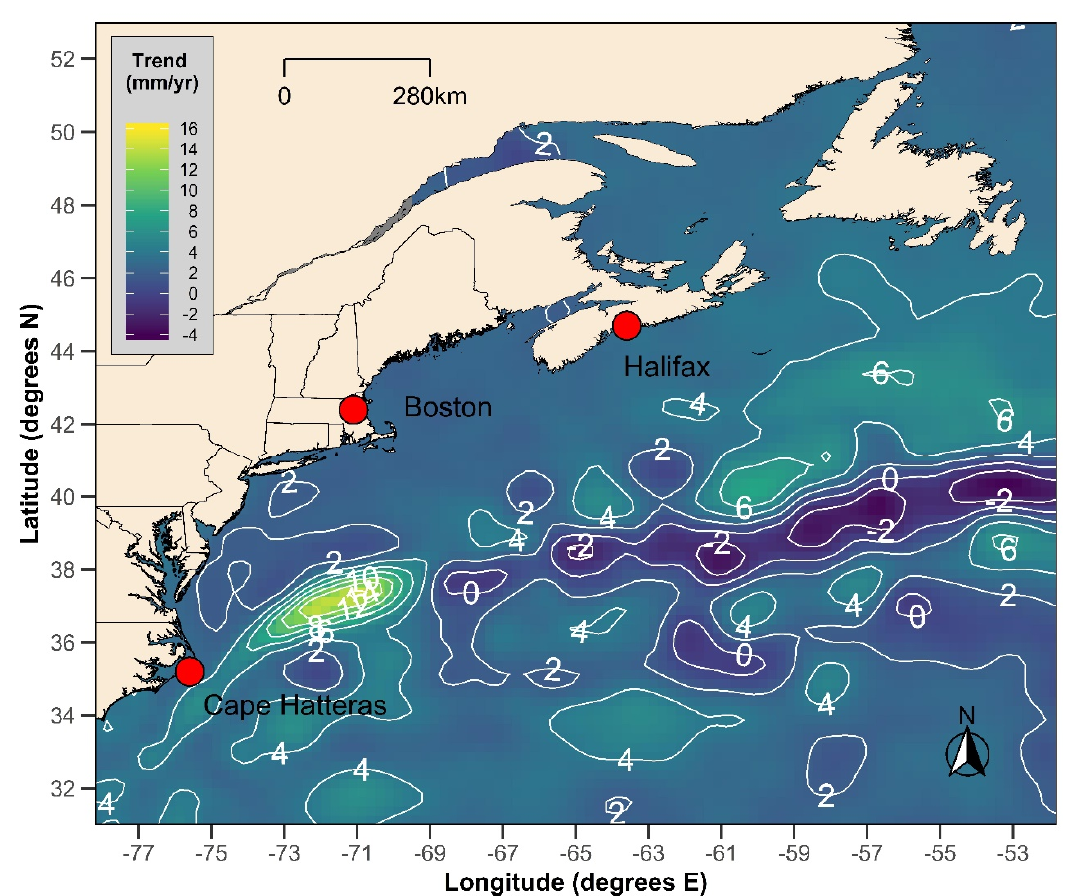
Figure 10. Panel 4—SSHA trends (September 1992–October 2019) from AVISO data [30]. Trend contours are advised at 2 mm/year intervals. Refer also to Figure 6.